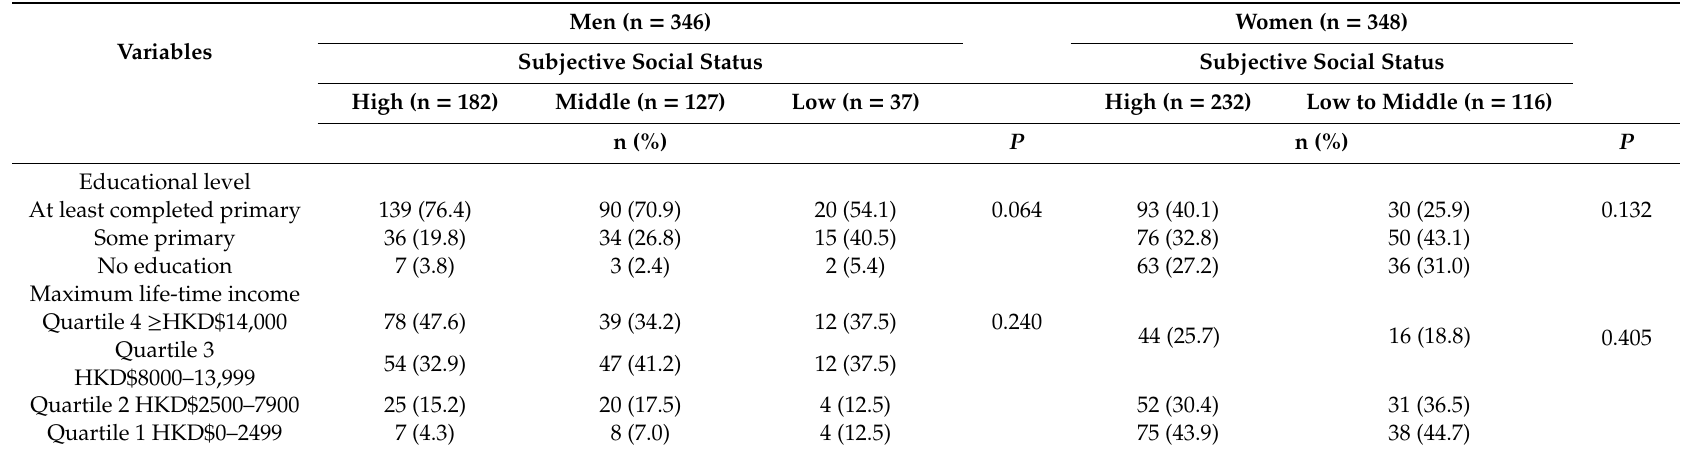
Table 2. Association between subjective social status (community status ladder), educational level, and maximum life-time income by sex (n =